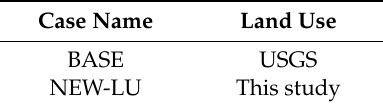
Table 1. Sensitivity simulation cases for meteorological fields and database used in each